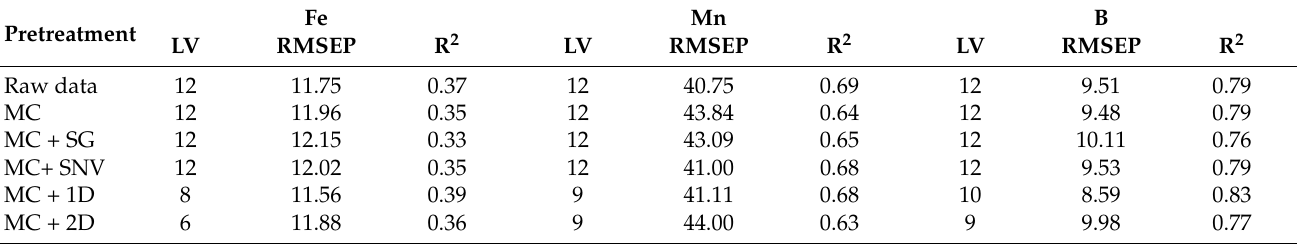
Table 4. Comparative statistics and uncertainty indices (R 2 and RMSEP) on reflectance for the test sets of the model generated by PLS-R for micronutrients (Fe, Mn and B). Mean center (MC),